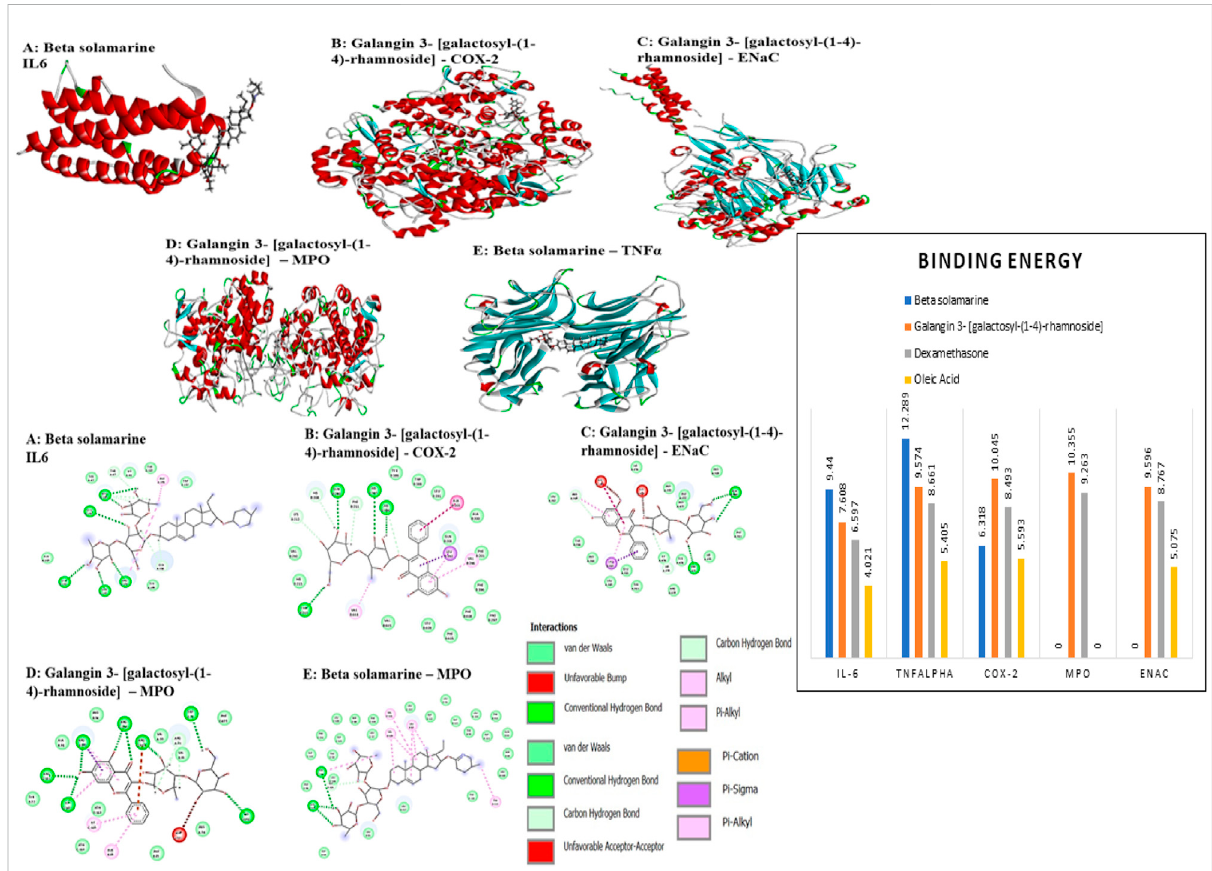
FIGURE 4 Docking interaction and binding energy comparison between phytoconstituent and molecular targets of ALI. Molecular coupling analysis revealed two phytoconstituents, i.e., beta-Solamarine and Galangin-3- [galactosyl-(1 – 4)-rhamnoside showed signi fi cant binding energy to the reported targets compared to dexamethasone. A pictorial representation of the 2D receptor-ligand interaction (A) : Beta-solamarine with IL-6, (B) Galangin-3- [galactosyl-(1 – 4)-rhamnoside with COX-2, (C) Galangin-3- [galactosyl-(1 – 4)-rhamnoside with ENaC, (D) Galangin-3- [galactosyl-(1 – 4)-rhamnoside with MPO and (E) Beta solamarine with MPO) and a comparison of binding energy in the graph are shown